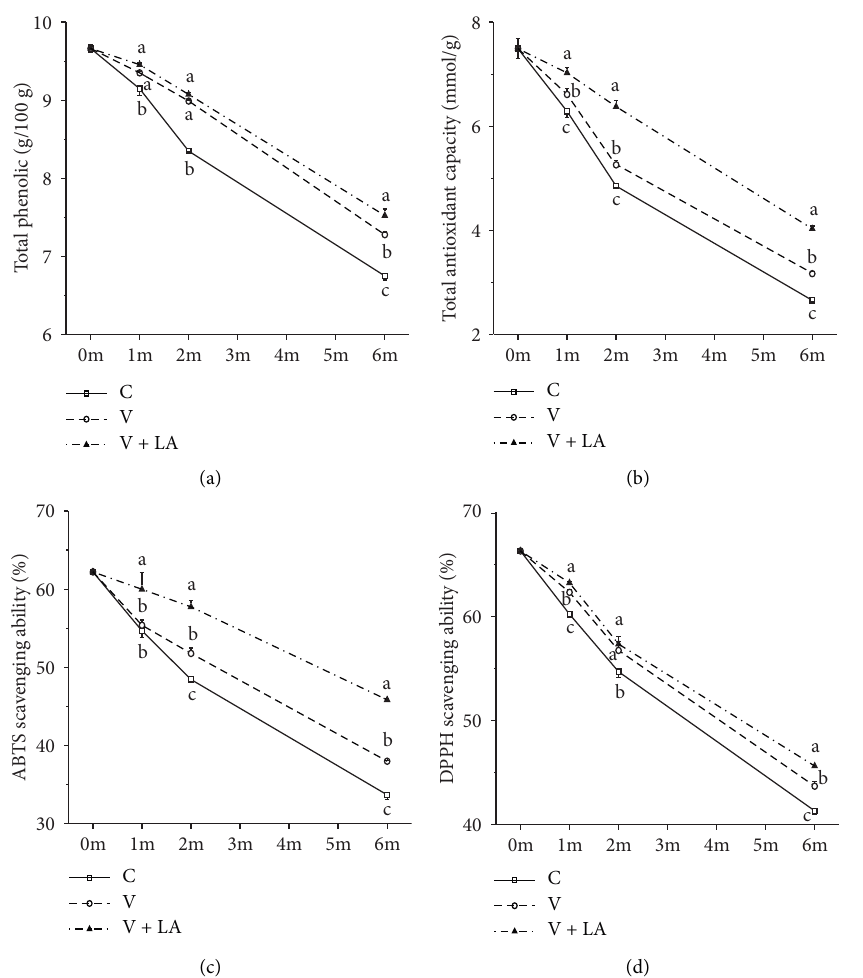
Figure 4: Efect of diferent packaging on total phenolic content, (a) total antioxidant capacity, (b) ABTS, (c) and DPPH (d) scavenging activity of the dried peppers during storage. C: control with polyamide/polyethylene flm; V : vacuum packaging with polyamide/poly- ethylene flm; V +LA: vacuum and light-avoided packaging with aluminum polyethylene flm. a–c represent the signifcant diference ( P < 0 . 05) of dried pepper stored in diferent